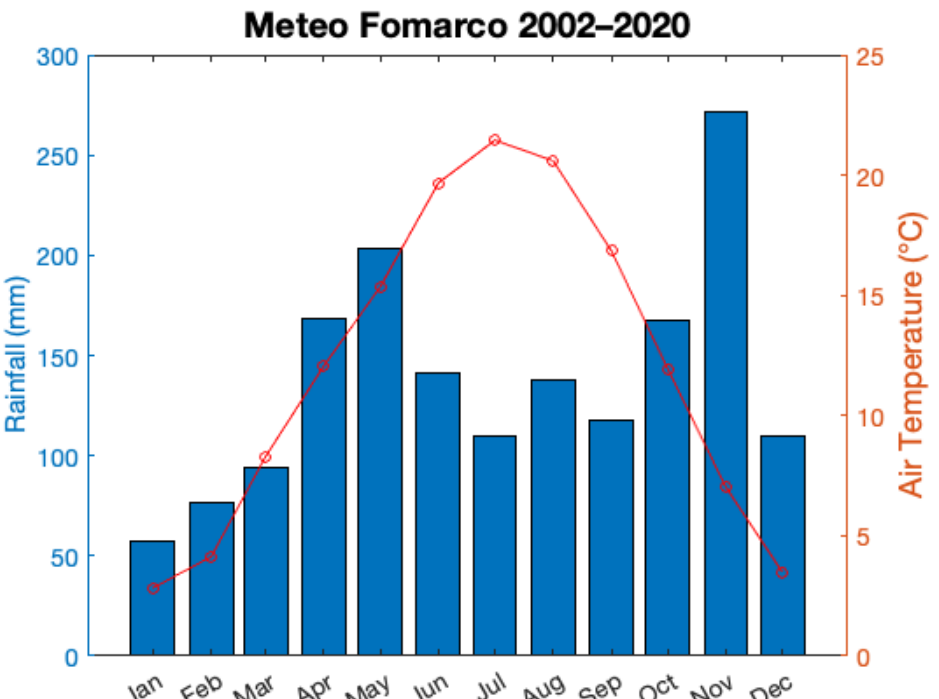
Figure 2. Mean monthly pattern of air temperature and total rainfall as recorded at the meteorological station in Fomarco (hamlet of Pieve Vergonte), operated by ARPA Piemonte (http://www.arpa.piemonte.it/; accessed on 26 April 2021). Air temperature values were calculated as averages of daily mean temperatures of a specific month over the period 2002–2020. Rainfall values represent averages of total monthly rainfall for a specific month over the period 2002–2020.